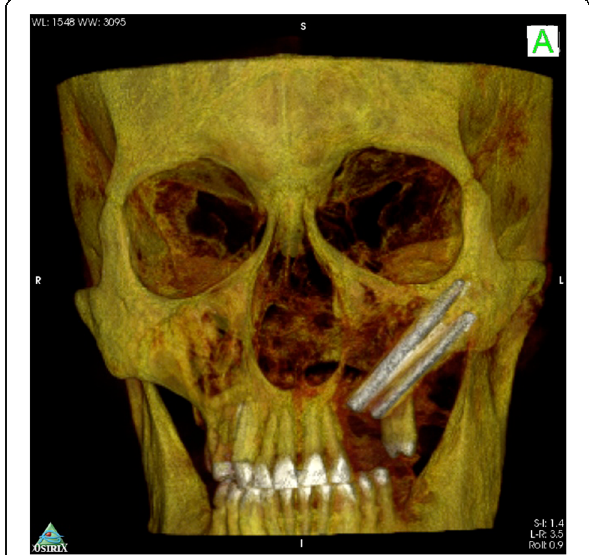
Fig. 5 Pt no. 1. X-ray follow-up examination showing the final dental prosthetic